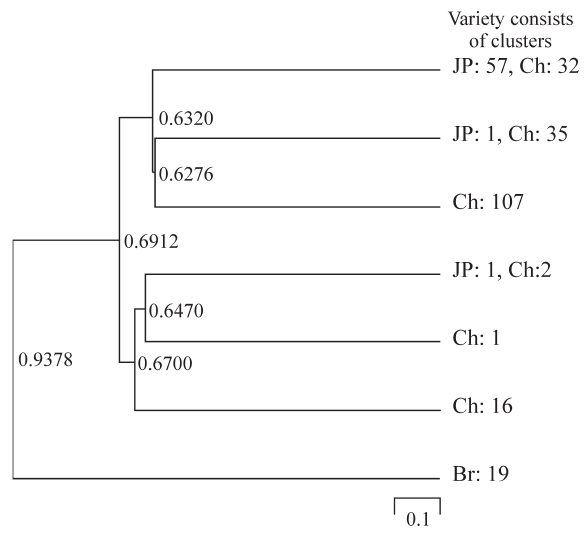
Figure 2 - Unweighted pair group method with averages (UPGMA) dendrogram constructed for the 272 soybean cultivars used in this study. The genetic distance and absolute Bootstrap value from 1,000 replications at each branching point are also shown. Each cluster was formed based on the genetic distances being equal to 0.600, and was labeled the origin (Jp = Japan, Ch = China and Br = Brazil) and the number of cultivars pres- ent in the